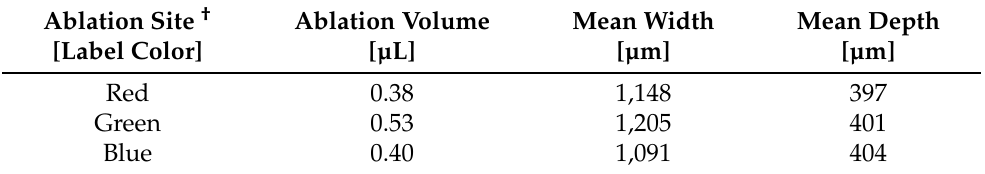
Differential quantitative proteome analysis of the murine colon tissue and the spleen tissue (three biological replicates from each tissue) sampled with NIRL resulted in 1889 identified proteins (see Supplementary Tables S1 and S2), wherein a total of 501 proteins had quantitative data in all samples. In Figure 3, the results of a principal component analysis (PCA) (see Supplementary Table S3) are shown as scatter plot visualization, where component 1 (73.4%) is plotted against component 1 (73.4%). The PCA of the 501 proteins revealed a clear tissue-related distinction between colon and spleen samples based on component 1. Thus, the biological differences between the samples based on the different tissue types have the greatest influence. The biological replicates within a sample group play a subordinate role, as they show a low Euclidean distance in the scatter plot visualization of PCA, representing a high grade of similarity. This is also shown by the further results of the PCA, which show that only an explained variance of 14.7% could be calculated for component